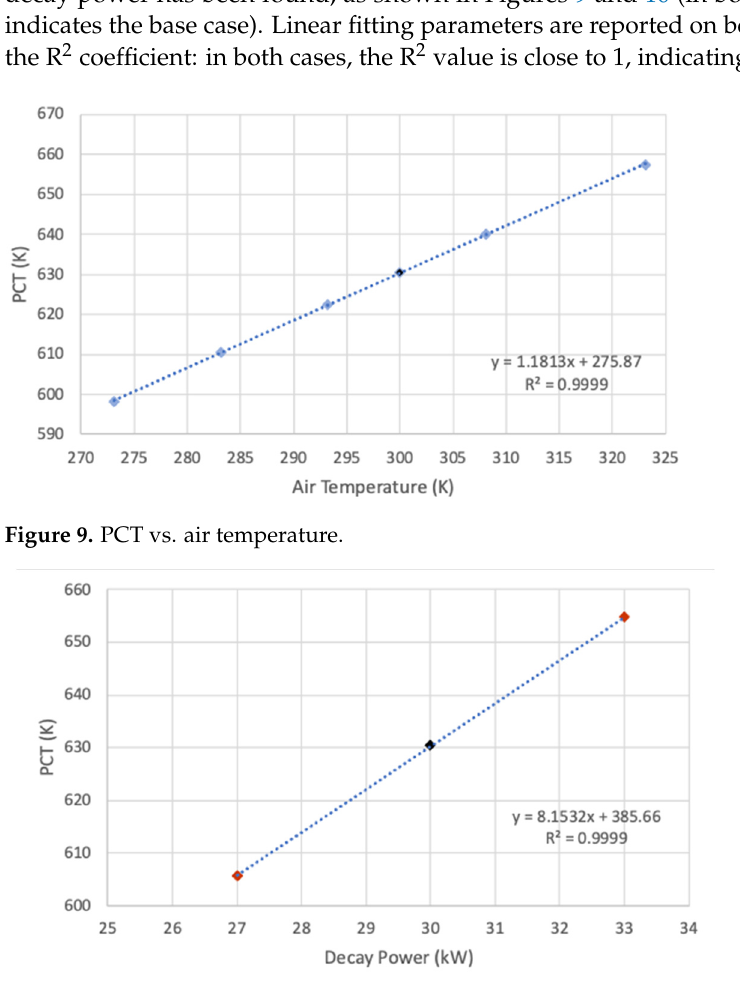
Figure 8. ( a ) The partial Pearson Coefficient ( left ) and partial Spearman Coefficient ( right ); ( b ) the p -values for the Pearson coefficient ( left ) and the p -values for the Spearman coefficient ( right ). 4.2.2. Sensitivity Analysis Concerning the sensitivity analysis, decay power and air temperature have been ad- dressed to assess the behavior of the system following their variation. A total of seven